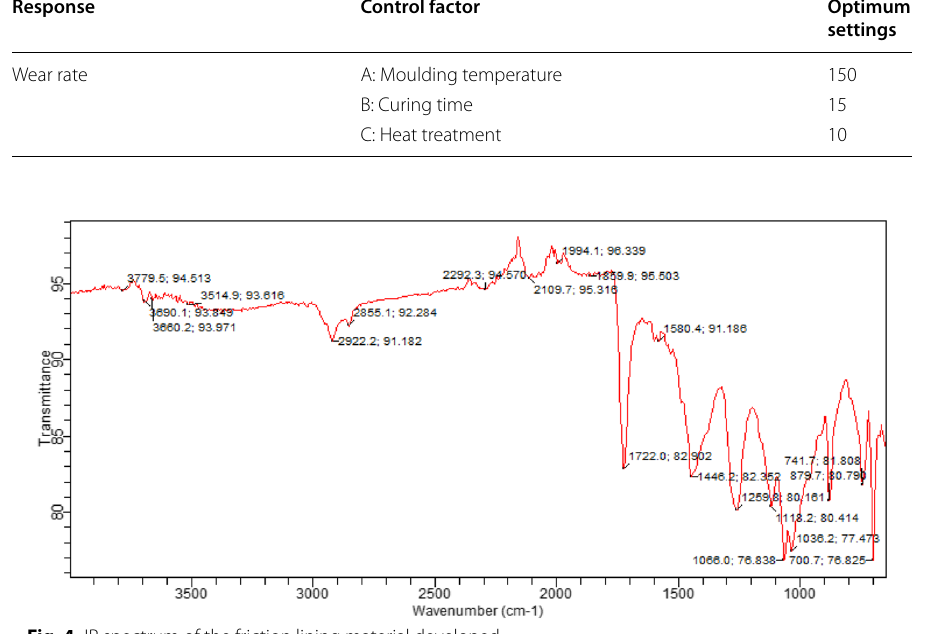
Fig. 4 IR spectrum of the friction lining material